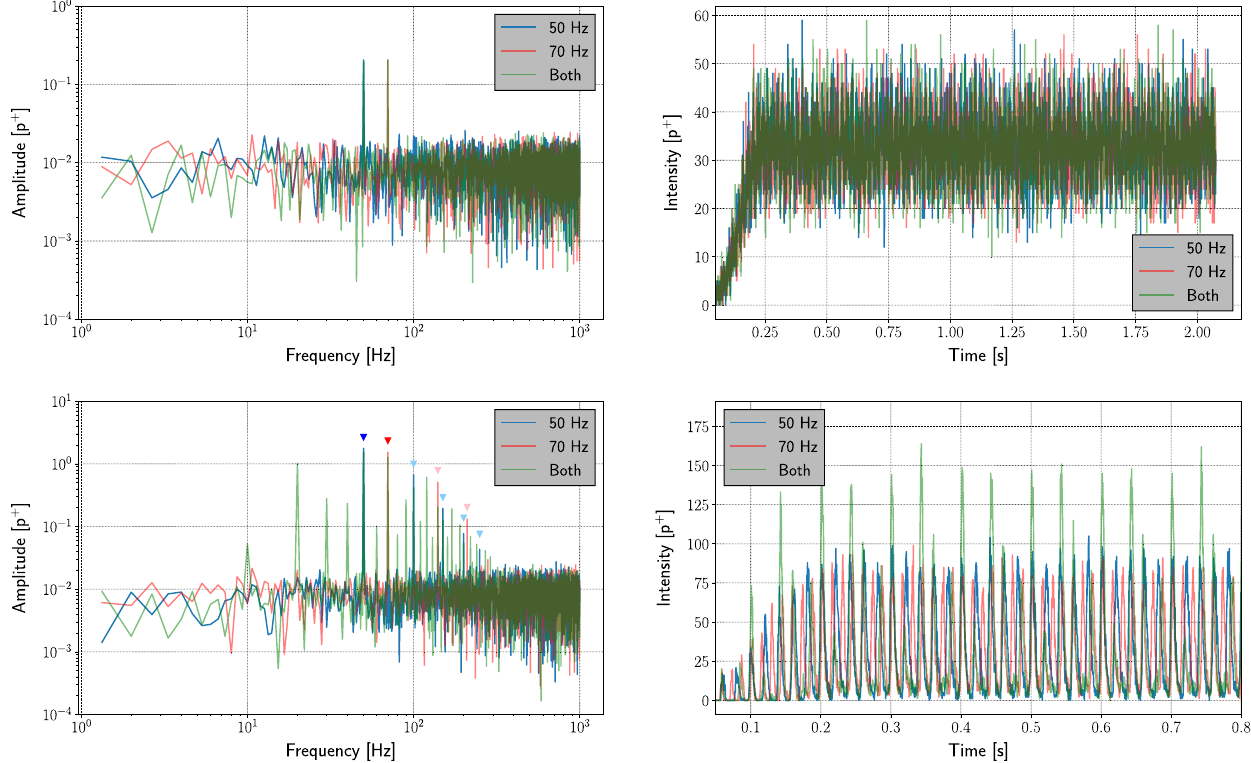
FIG. 3. Ripple signal spectra (left) and corresponding extracted spills (right) obtained by injecting 50 and 70 Hz ripple signals of equal amplitude, both separately and together. Top plots: ripple amplitudes below linearity threshold. Bottom plots: above linearity threshold; the single injected main frequencies and harmonics are highlighted respectively by full color and faded